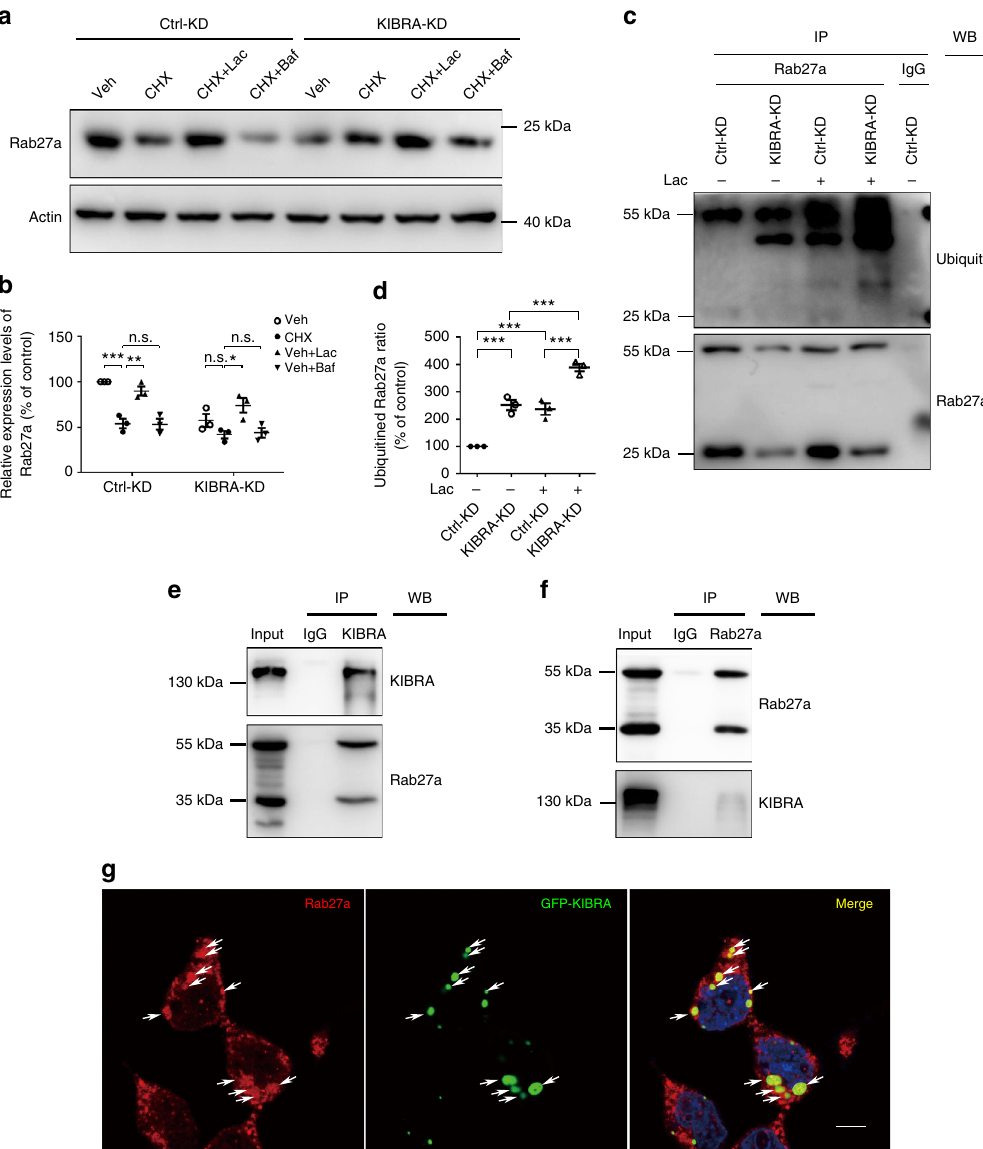
Fig. 5 KIBRA stabilizes Rab27a and prevents it from being ubiquitinated. a Western blot was performed to determine the level of Rab27a in KIBRA-KD and Ctrl-KD cells treated with cycloheximide (CHX) for 12 h to inhibit protein synthesis. Meanwhile, the medium was supplemented with the proteasome inhibitor lactacystine (Lac) or the lysosome inhibitor ba fi lomycin A1 (Baf). Cells treated with vehicle were used as a control. b Quanti fi cation of Rab27a levels in three independent experiments. c KIBRA-KD and Ctrl-KD cells were treated with Lac or vehicle for 12 h before being lysed and immunoprecipitated using anti-Rab27a antibody or IgG. Ubiquitinated Rab27a levels were determined by western blotting with the anti-ubiquitin antibody. d Quanti fi cation of ubiquitinated Rab27a levels in three independent experiments. e 293T cells were cotransfected with GFP-KIBRA and DsRed-Rab27a. The cells were lysed 48 h after transfection and immunoprecipitated using anti-KIBRA antibody or IgG. The association between KIBRA and Rab27a was determined by western blotting with the anti-Rab27a antibody. f 293T cells were cotransfected with GFP-KIBRA and DsRed-Rab27a. Cells were lysed 48 h after transfection and immunoprecipitated using anti-Rab27a antibody or IgG. The association between KIBRA and Rab27a was determined by western blotting with the anti- KIBRA antibody. g 293T cells were transiently transfected with GFP-tagged KIBRA (green). After 24 h, the cells were fi xed and stained with antibody against Rab27a (red). Scale bar = 10 μ m. White arrows indicate the small punctate structures where KIBRA and Rab27a were co-localized. The quanti fi cation results were plotted as dot plots, showing the mean ± SE. * P < 0.05, ** P < 0.01, *** P < 0.001. n.s., not signi fi cant ( P > 0.05) as determined